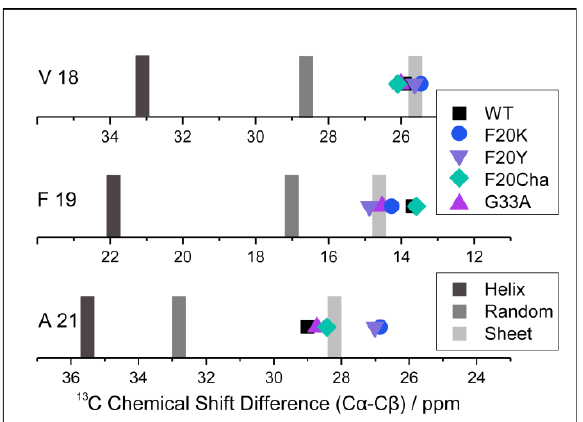
Figure 4. 13 C NMR C α –C β chemical shift differences of the A β 40 fibril variants (symbols) and reference values for α -helix, random coil and β -sheet structure (gray bars) for the labeled amino acids Val 18 , Phe 19 and Ala 21 . 13 C α – 13 C β chemical shift differences represent a measure of the local secondary structure, which is independent of external chemical shift referencing.